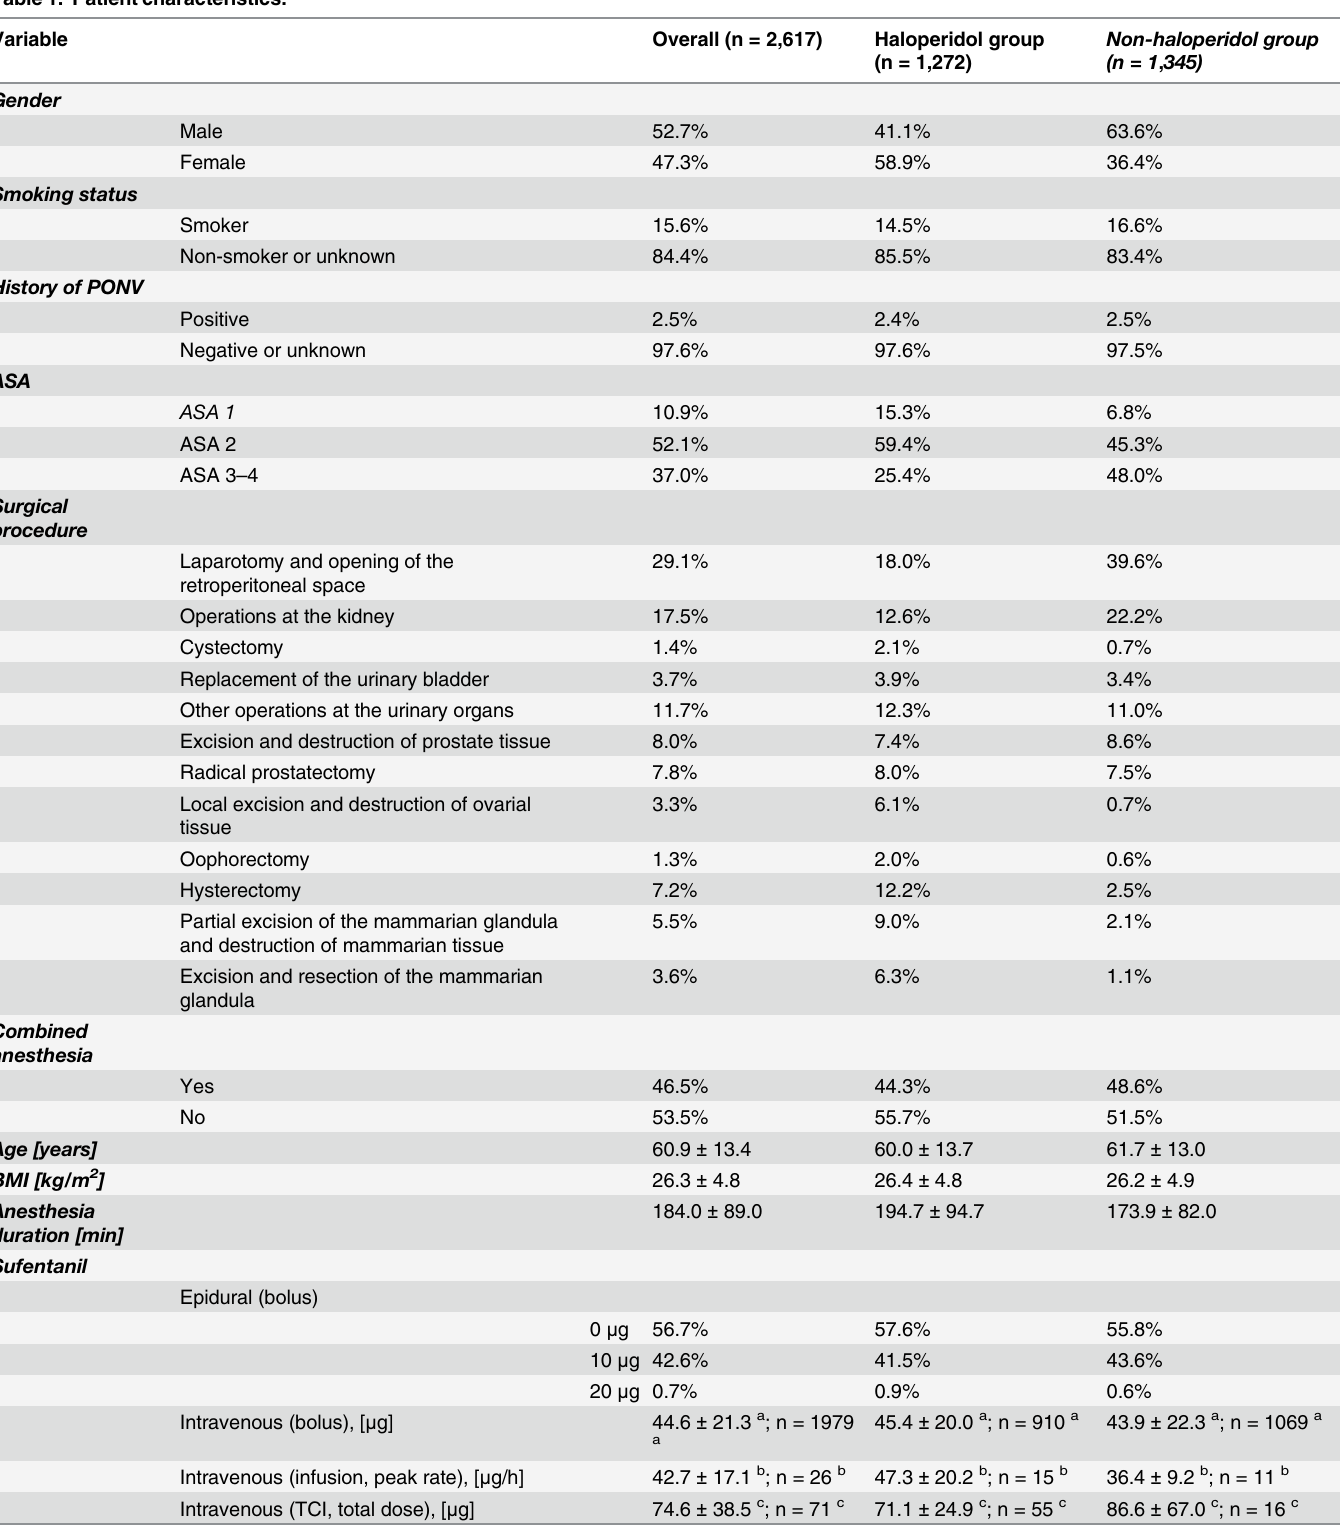
Table 1. Patient